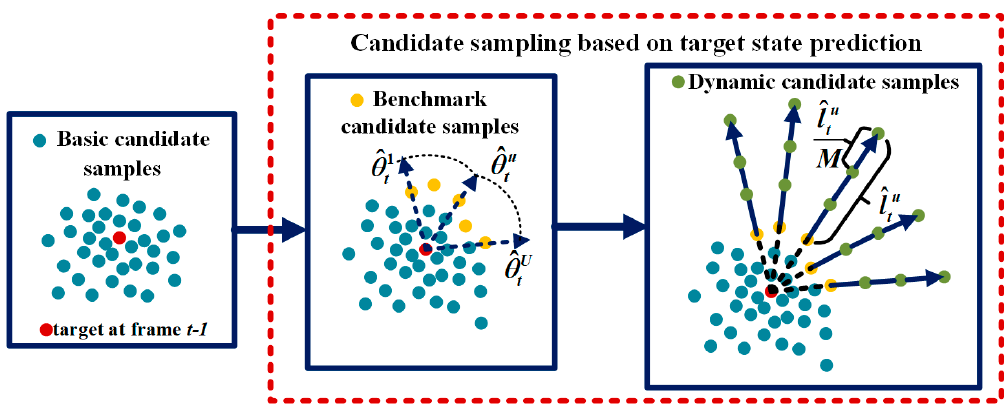
Figure 3. First, the basic candidate samples (the blue dots) are obtained around the target location at frame t − 1. Second, the basic candidate samples with the largest relative distance in each predicted direction will be selected as the benchmark candidate samples (the yellow dots). Third, adding more dynamic candidate samples (the green dots) in the predicted direction begins from the benchmark within a predicted distance.